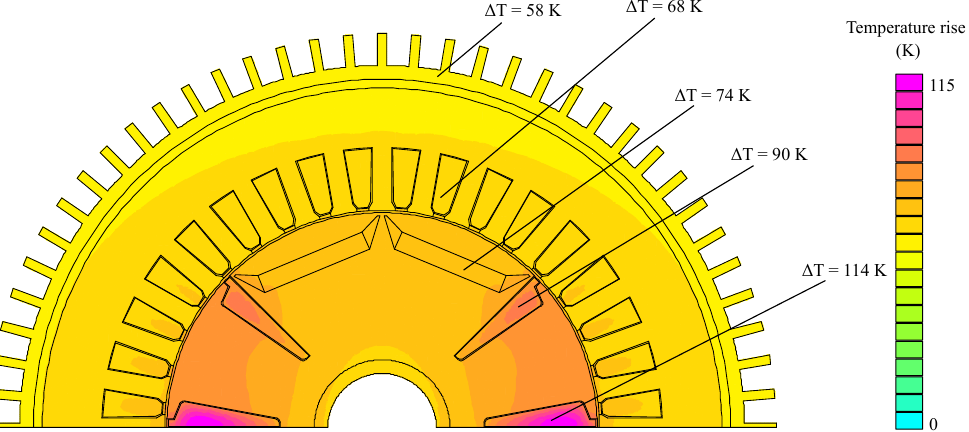
Figure 29. Temperature increase map with air cooling and oil flux along the shaft.